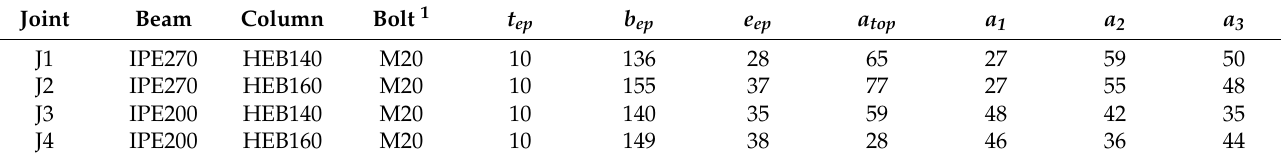
Table 6. Final connection details (size in mm).